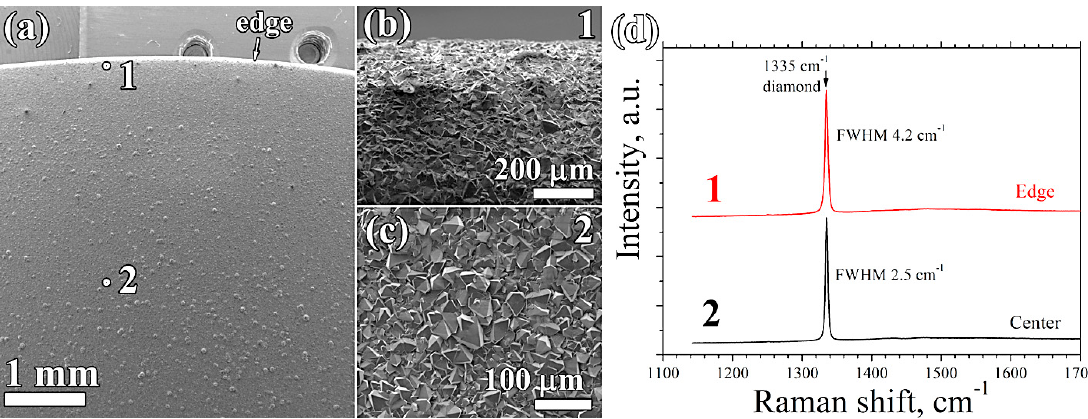
Figure 5. SEM images of the surface of PCD film grown with MPCVD technique in pedestal substrate holder: ( a ) general view of PCD surface near the edge area; ( b , c ) close-up pictures from points 1 and 2; ( d ) Raman spectra taken from points 1 and 2.